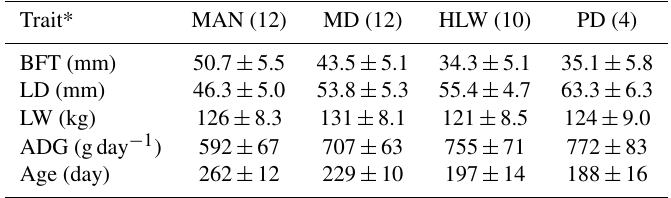
Table 1. BFT, LD, LW, ADG, and age in the analyzed groups ( n ), presented as mean ±